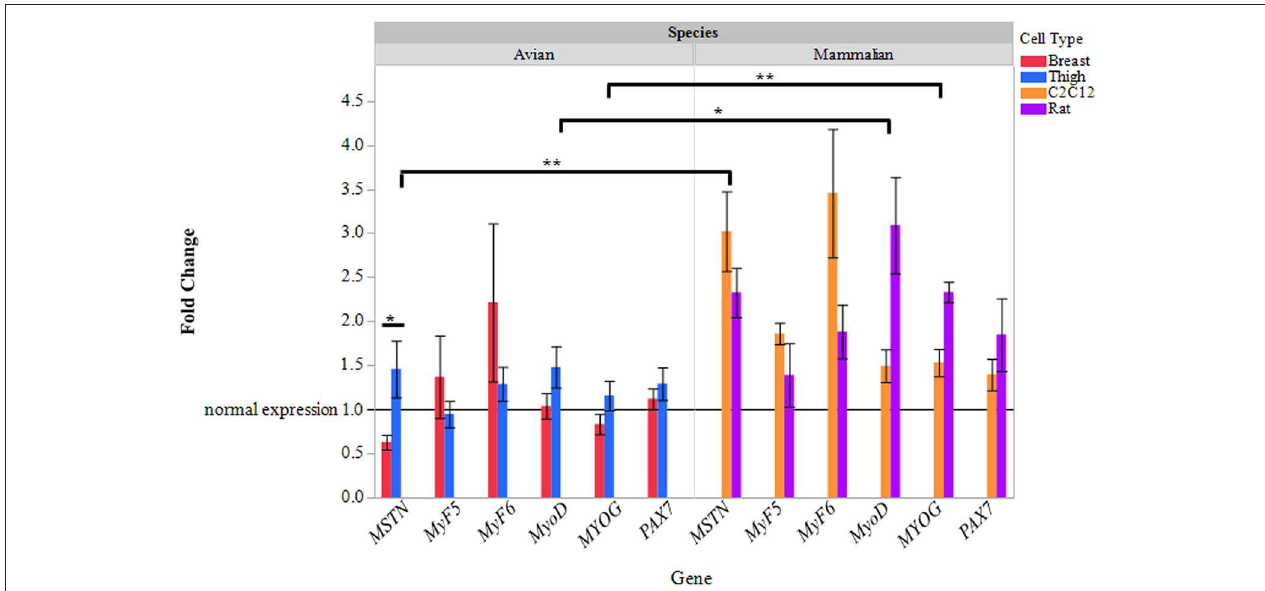
FIGURE 1 | Relative gene expression of myotubes treated with ammonium acetate. mRNA expression of MSTN, MyF5, MyF6, MyoD, MYOG, and Pax7 in primary breast, primary thigh, C2C12, and primary rat differentiated myotubes after 24h of treatment with ammonium acetate (10mM) measured by quantitative real time PCR. Fold changes were calculated using myotubes treated with 10mM sodium acetate as control samples, and all samples were normalized using β -actin as a reference gene. Fold changes are expressed as a mean ( n = 5) ± SE. The reference line at 1 represents gene expression of sodium acetate controls. Asterisks represent significant differences between cell or species gene expression (* P < 0.05; ** P < 0.01).